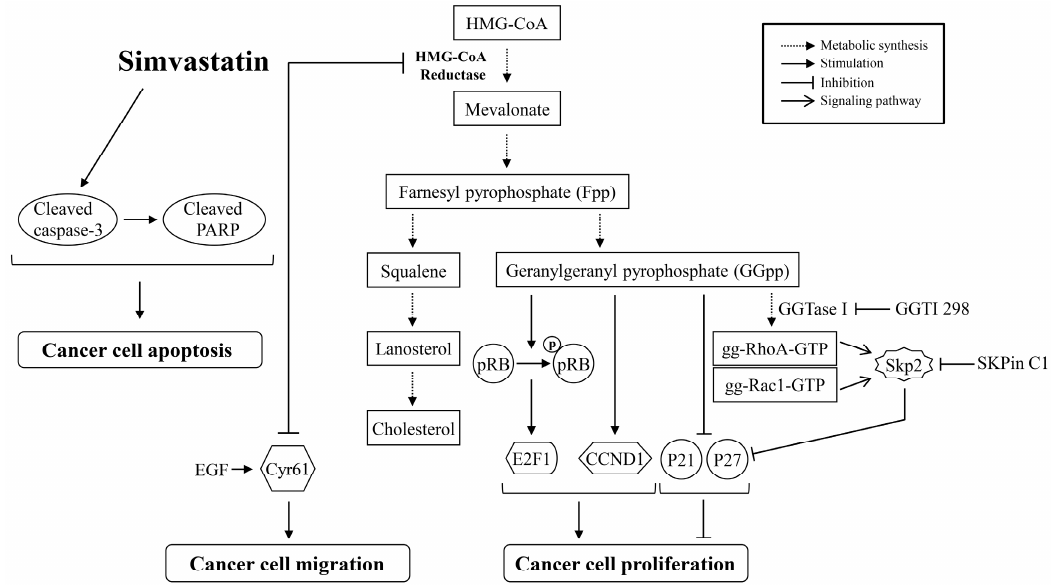
Figure 8. Simvastatin reduces cell proliferation and migration and triggers apoptosis in ATC cells. Incubation of ATC cells, SW1736 and 8305C, with simvastatin produces cell proliferation inhibition via inactivation of RhoA/Rac1 small GTPase protein, reduction of protein levels of CCND1, pp-Rb and E2F1, and increases of protein levels of p21 cip and p27 kip . Simvastatin causes cell migration inhibition via repression of Cyr61 expression. In addition, simvastatin induces apoptosis via caspase 3 and PARP activation. gg-Rac1-GTP, geranylgeranylated-Rac1-GTP; gg-RhoA-GTP, geranylgeranylated-RhoA-GTP; pp-Rb,